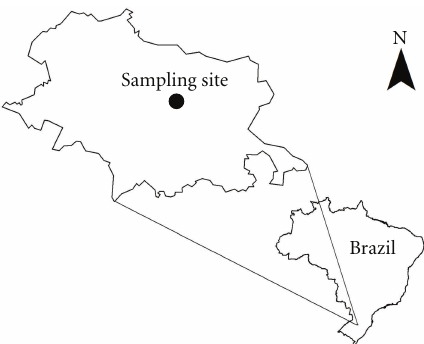
Figure 1: Location of the sampling site in Passo Fundo,